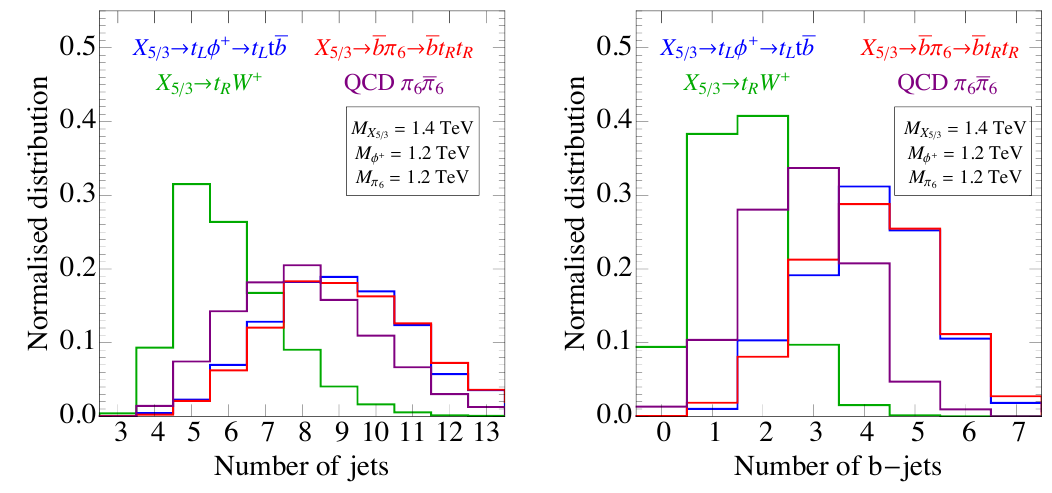
Figure 6 . Number of jets (left) and b -jets (right) for various decay modes of the X pair production. The distributions are obtained after the SSL search cuts (see section